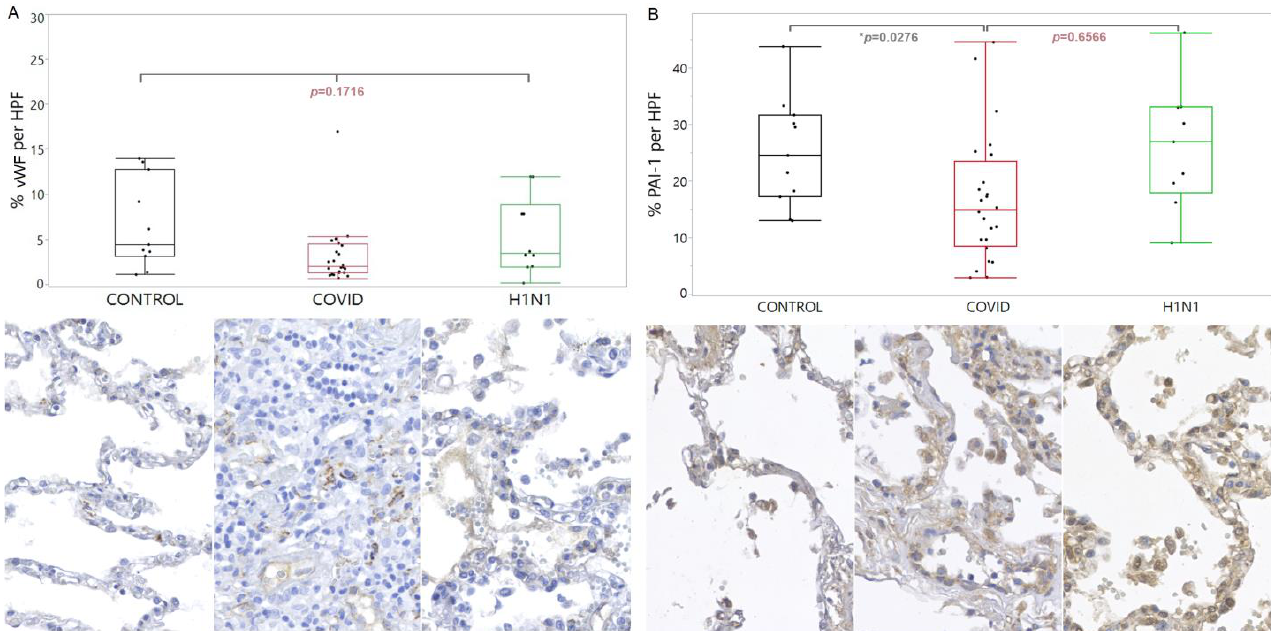
Figure 2. Comparison of the levels of vWF ( A ) and PAI-1 ( B ) proteins in tissue samples from COVID-19 patients versus control and H1N1pdm09 patients. The data is presented as a graphical representation of the group comparison and the corresponding immunohistochemistry staining images. The difference between the three groups was determined using the non-parametric Kruskal-Wallis test. When the three groups were significant, the Mann-Whitney test was applied in the two-by-two comparison, with significance (*) indicated by a p -value less than 0.05.